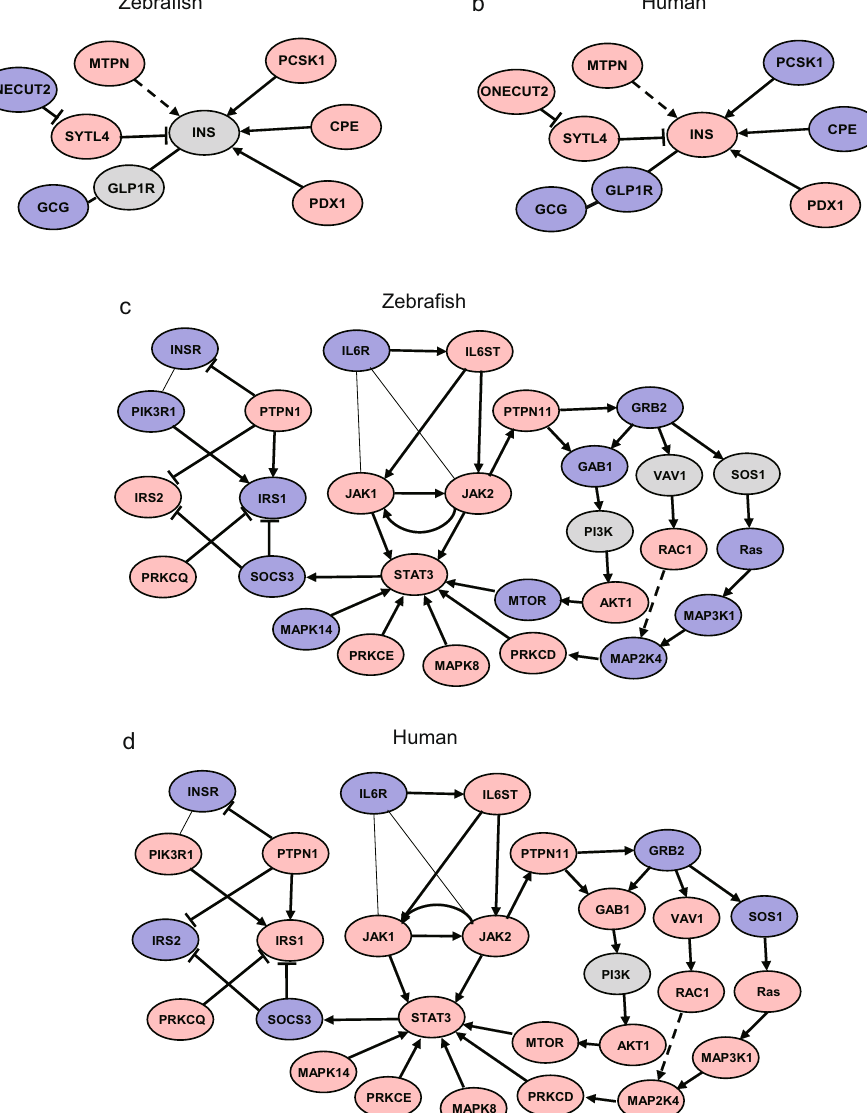
Figure 5. Pathways of insulin secretion in pancreas and insulin resistance in liver of DIO zebrafish and T2DM patients. Insulin secretion pathways in ( a ) DIO zebrafish and ( b ) pancreatic beta cells of T2DM human patients (GSE20966). Pathways of insulin resistance in ( c ) DIO zebrafish and ( d ) human hyperglycaemic liver (GSE23343). Red and blue denote genes with increased and decreased expression, respectively. Grey denotes genes that were not detected in the RNA-seq assay or DNA